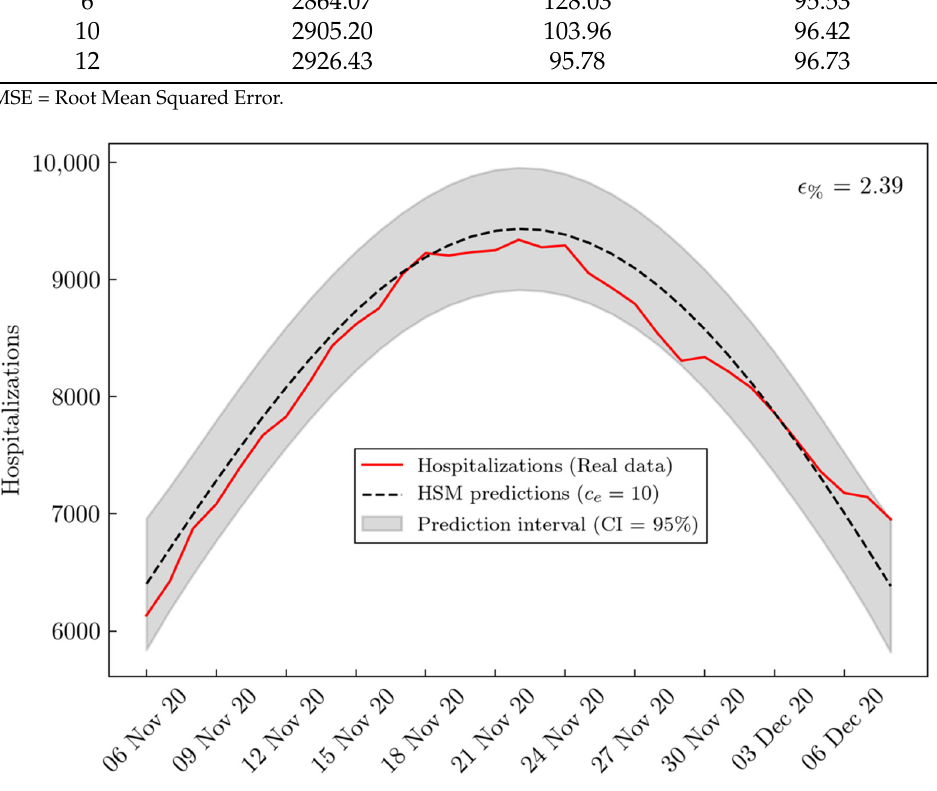
Figure 6. Real vs predicted hospitalizations in Lombardy. HSM predictions (dashed black line) for the average contact rate c e = 10 and real hospitalizations in Lombardy (straight red line) from 6 November to 8 December 2020 are reported. The 95% prediction confidence interval along with the average percentage error ( 𝜖 % ) between HSM hospitalization predictions and actual hospitalizations data are also reported.